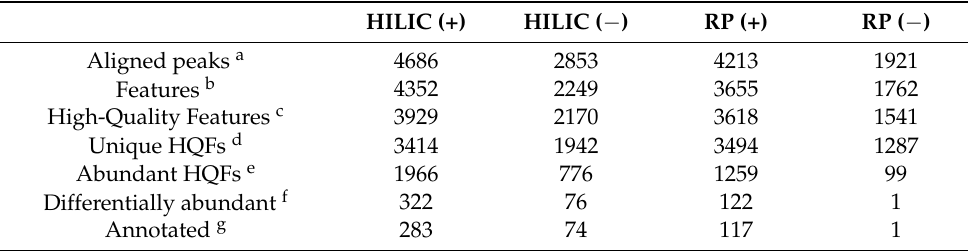
Table 1. LMW DOM coverage by HILIC and RP in positive- and negative-ion mode at each level of data filtering, expressed as the number of features detected across all 36 soil water extracts from 4 cores obtained from 2 polygon types and 2 species of